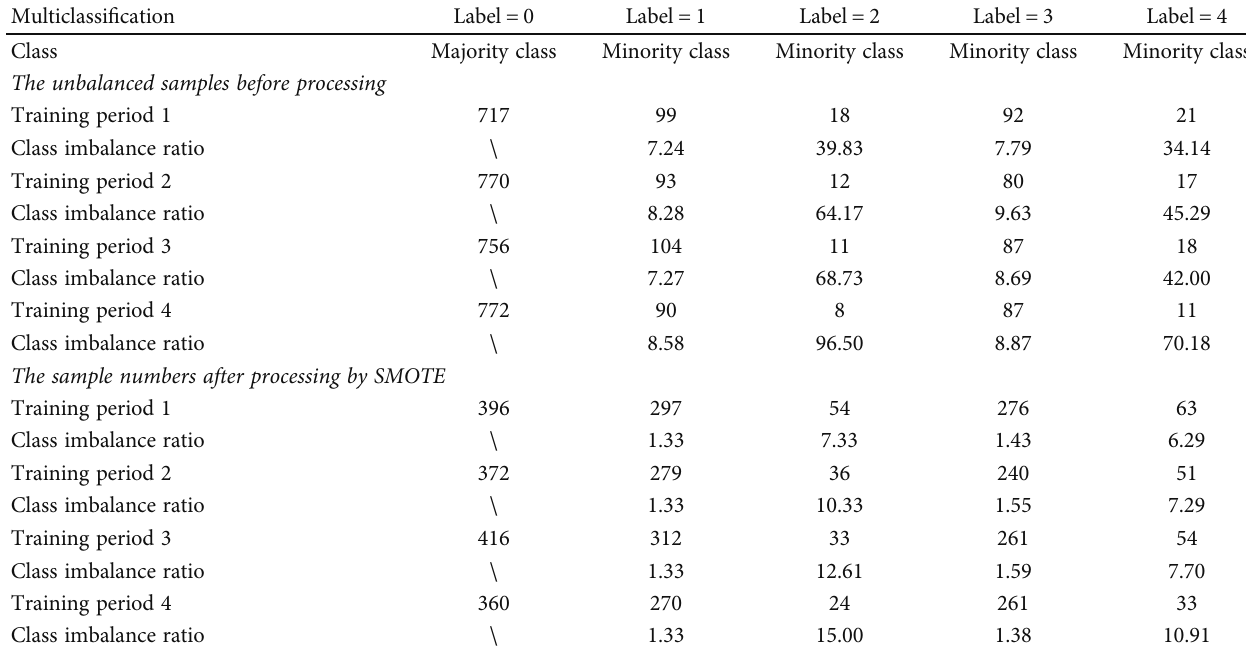
Table 2: The data preprocessing results of the SMOTE-based approach. Note that the class imbalance ratio = majority class/minority class